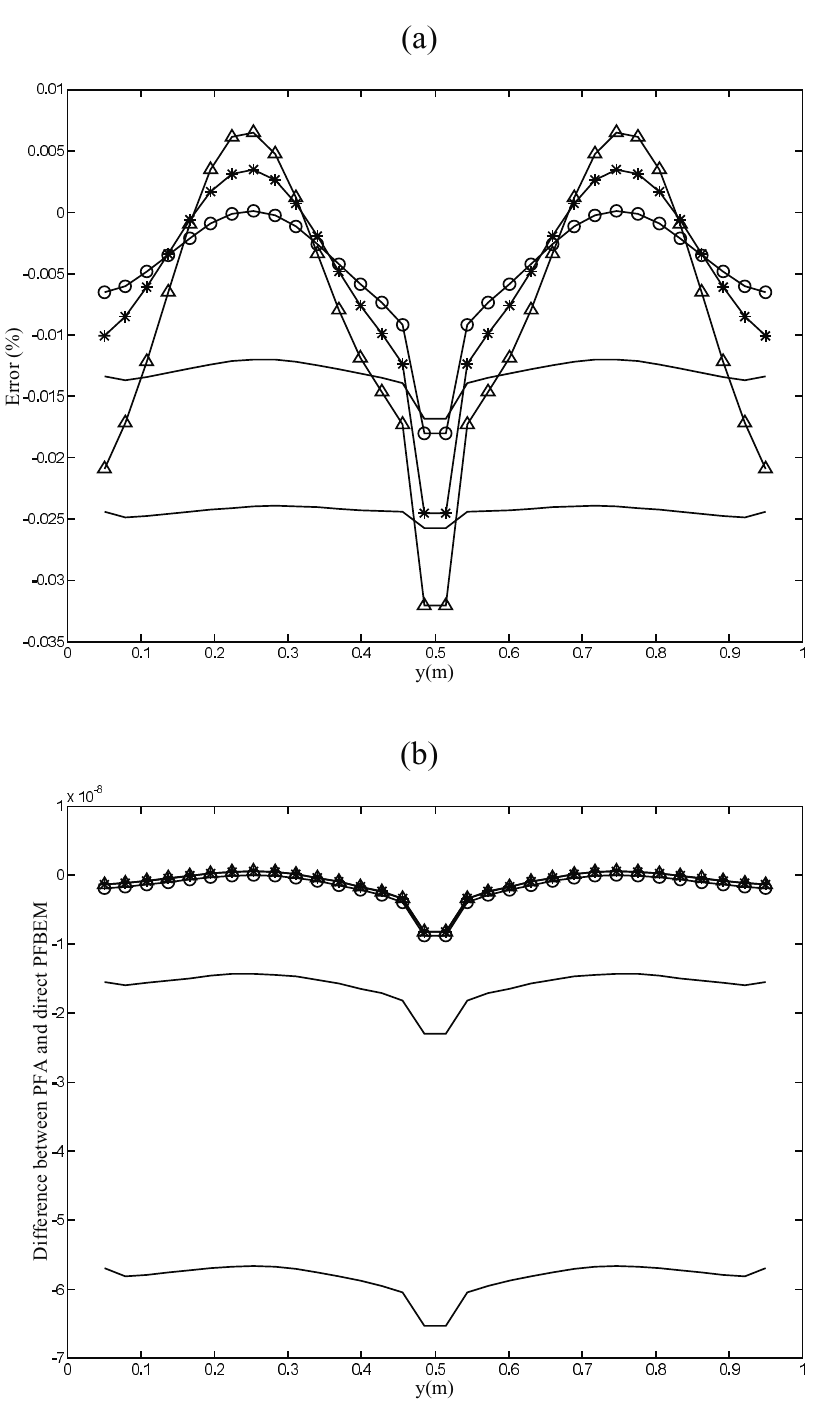
Fig. 9. Comparison of (a) error rate, (b) difference between EFA analytic solution and direct EFBEM solution along the representative line at various frequencies when η = 0 . 02 and the number of boundary elements is 64: —, f = 0 . 5 KHz; - - -, f = 1 kHz; , f = 4 kHz; , f = 8 kHz; , f = 16